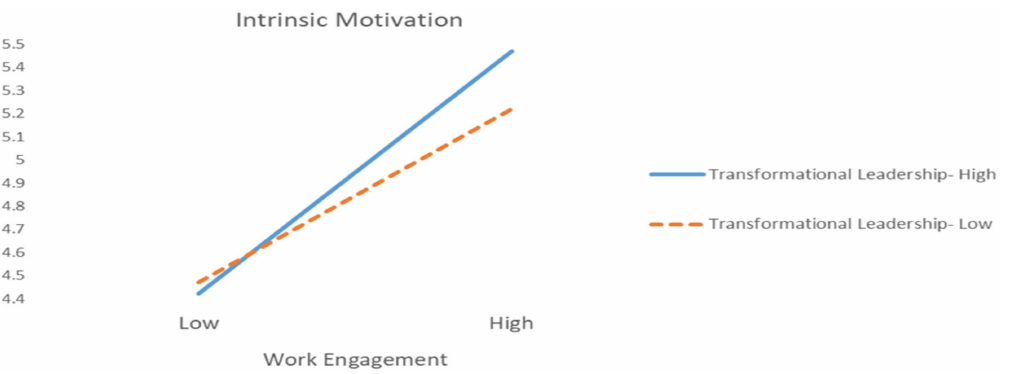
Figure 2. Plot of interaction between work engagement and transformational leadership on intrinsic